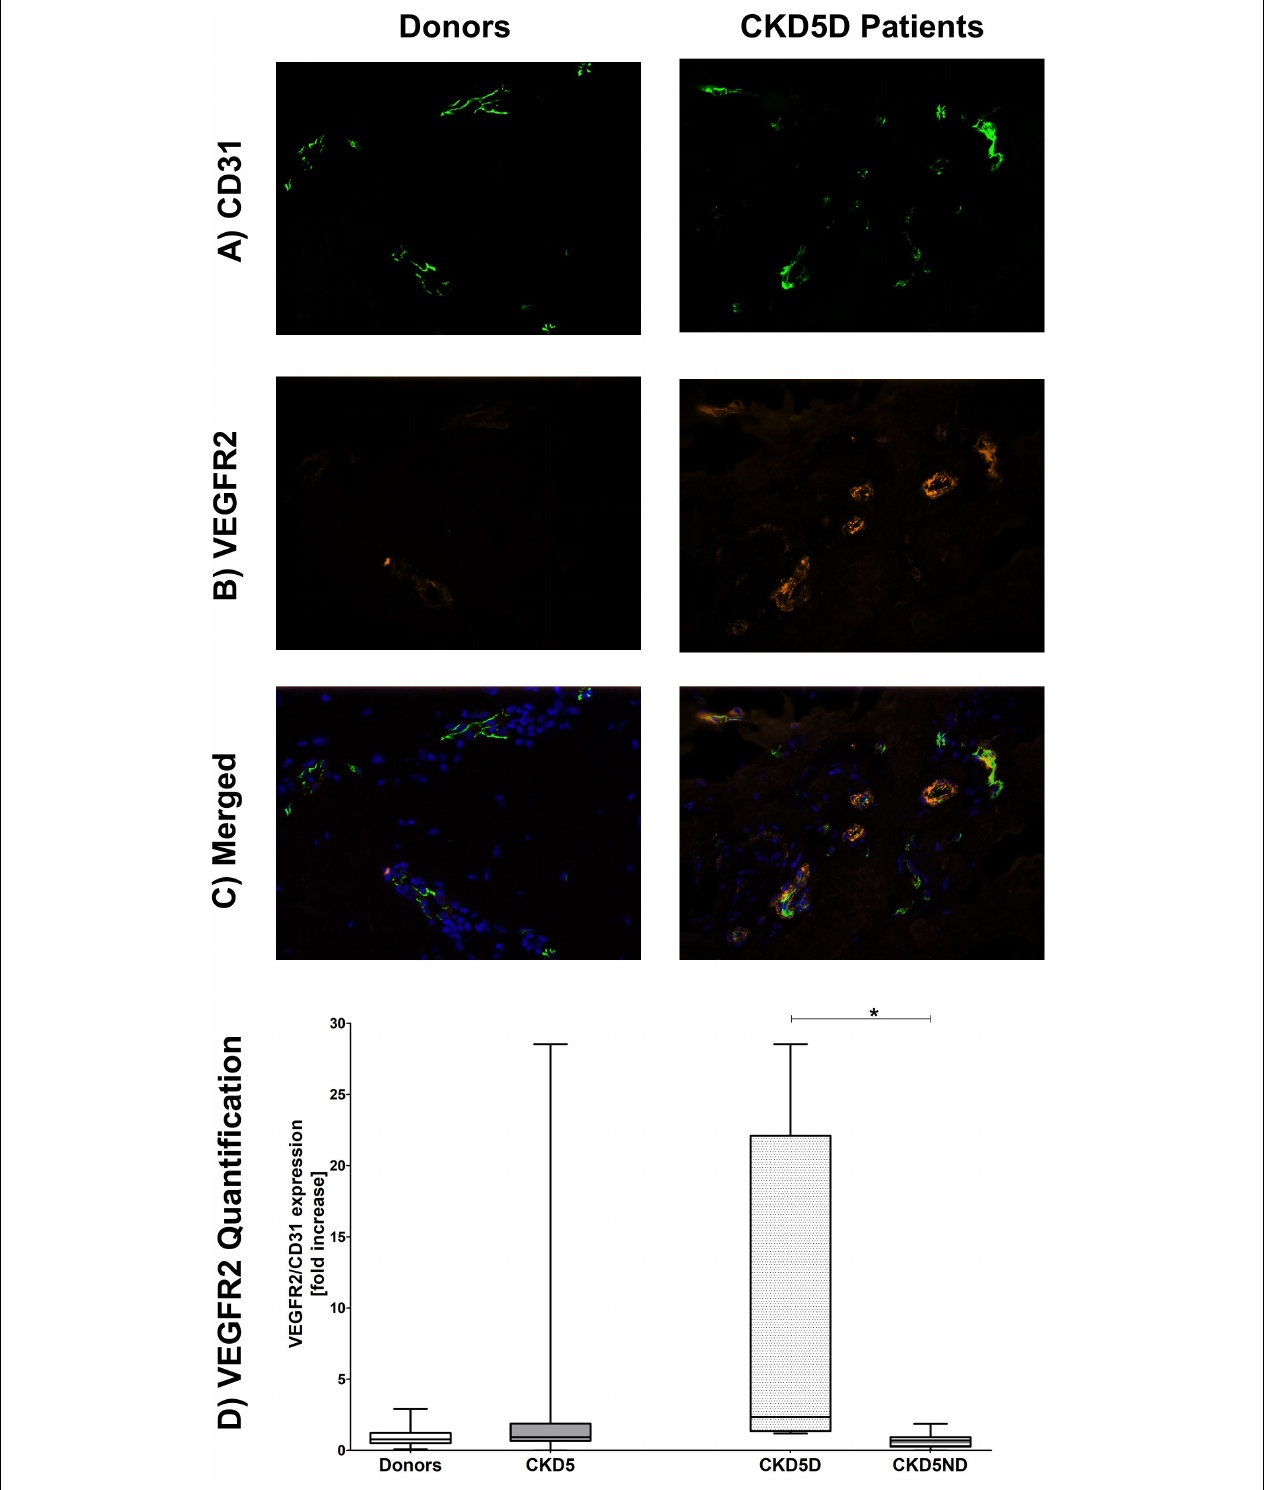
FIGURE 3 | Expression of VEGFR2 in the microvasculature of dermal biopsies in patients with CKD. (A) Expression of CD31 in donors (left image) and CKD5D patients (right image). (B) Expression of VEGFR2 in donors (left image) and CKD5D patients (right image). (C) Merged expression of VEGFR2 and CD31 in donors (left image) and CKD5D patients (right image). (D) VEGFR2 quantification with VEGFR2 expression relative to CD31. Colors in images: green = CD31; red = VEGFR2; blue = DAPI. Statistical significance: * P < 0.05.